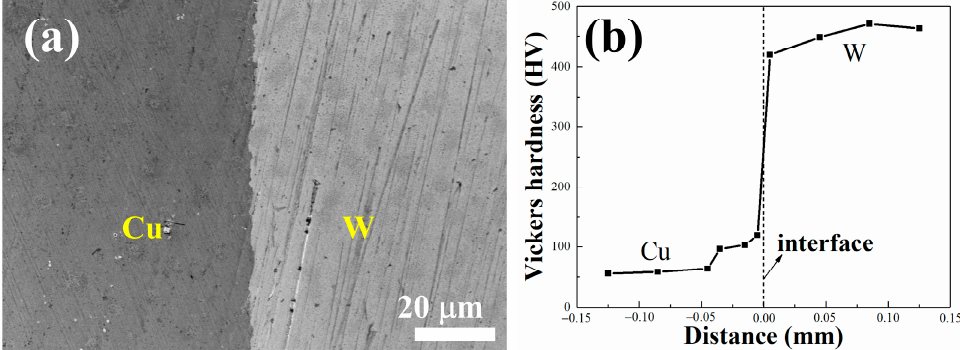
Figure 8. ( a ) The microstructure of the W/Cu joint achieved at 980 °C for 3 h with nano-treatment, ( b ) Vickers microhardness distribution along the cross-section of the W/Cu joint.